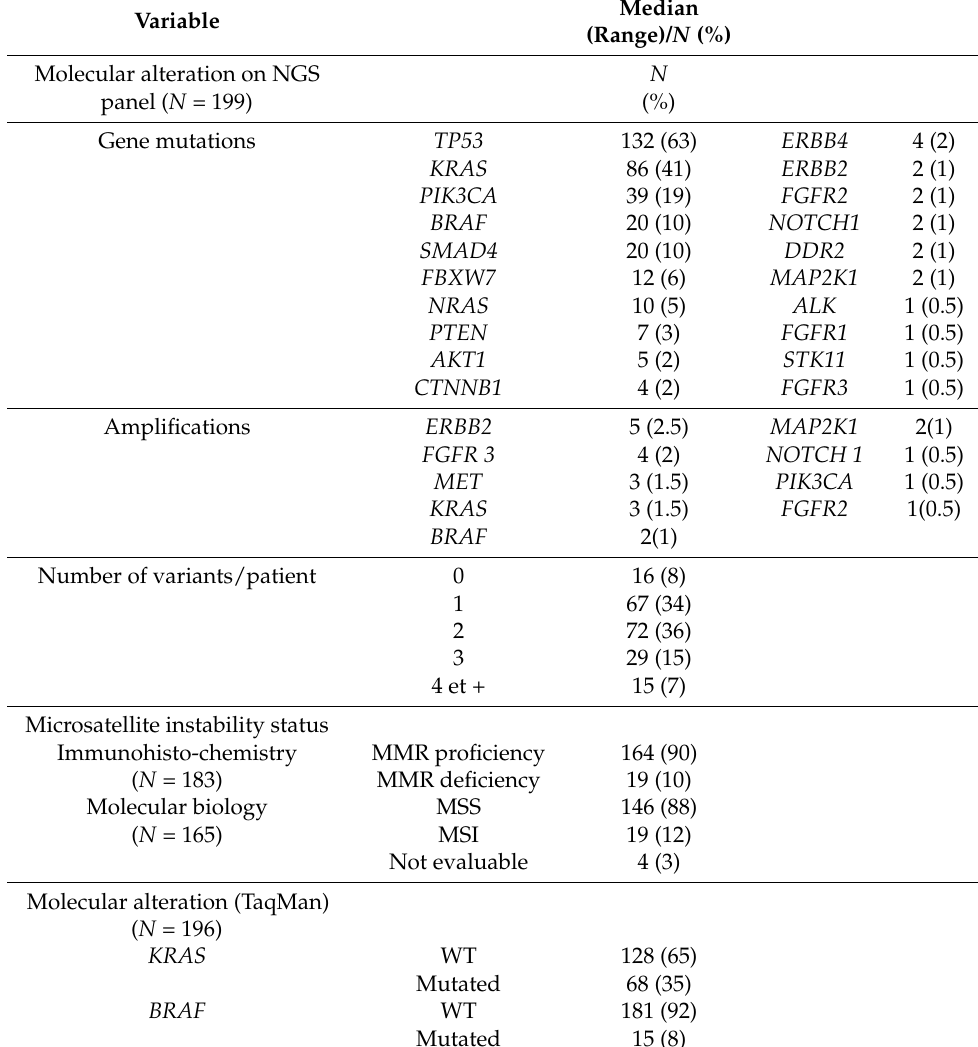
Table 2. Molecular